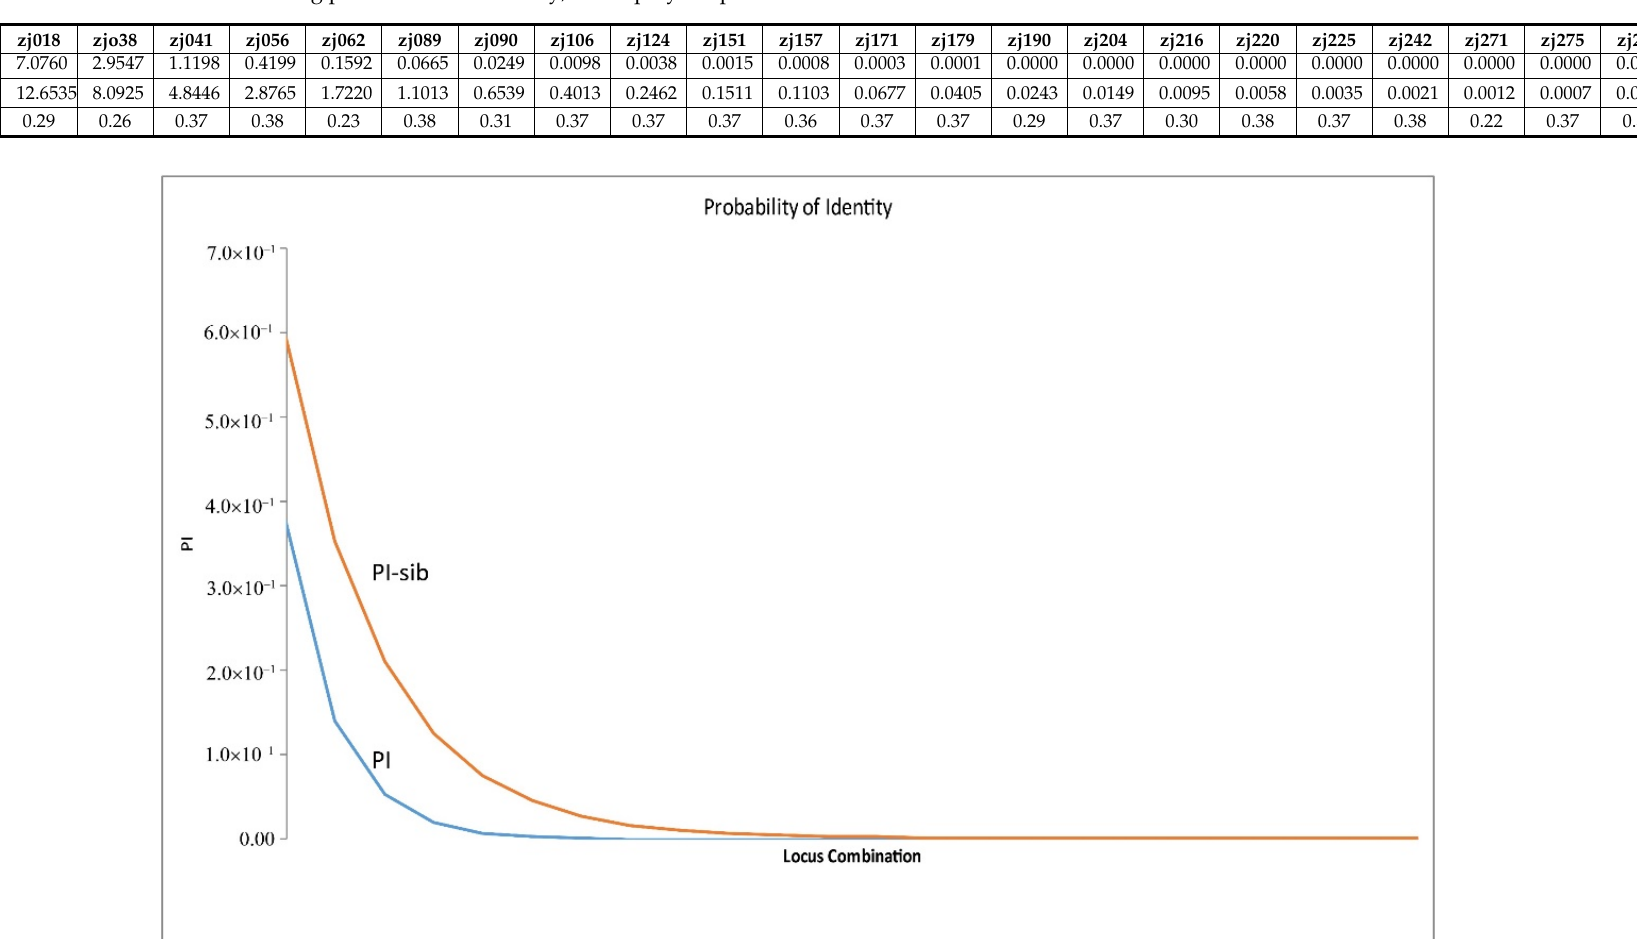
Table 5. Expected number of individuals with the same multilocus genotype for increasing locus combinations (number of loci = 24). PI = Probability of Identity; PID-sib = Sibling probabilities of identity; PIC = polymorphism information content.